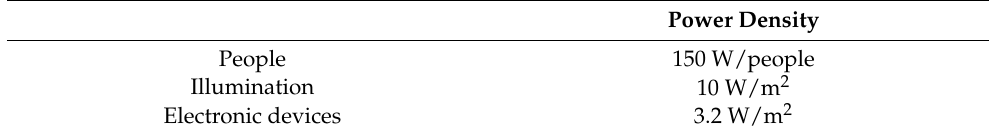
Table 4. Thermal loads form.